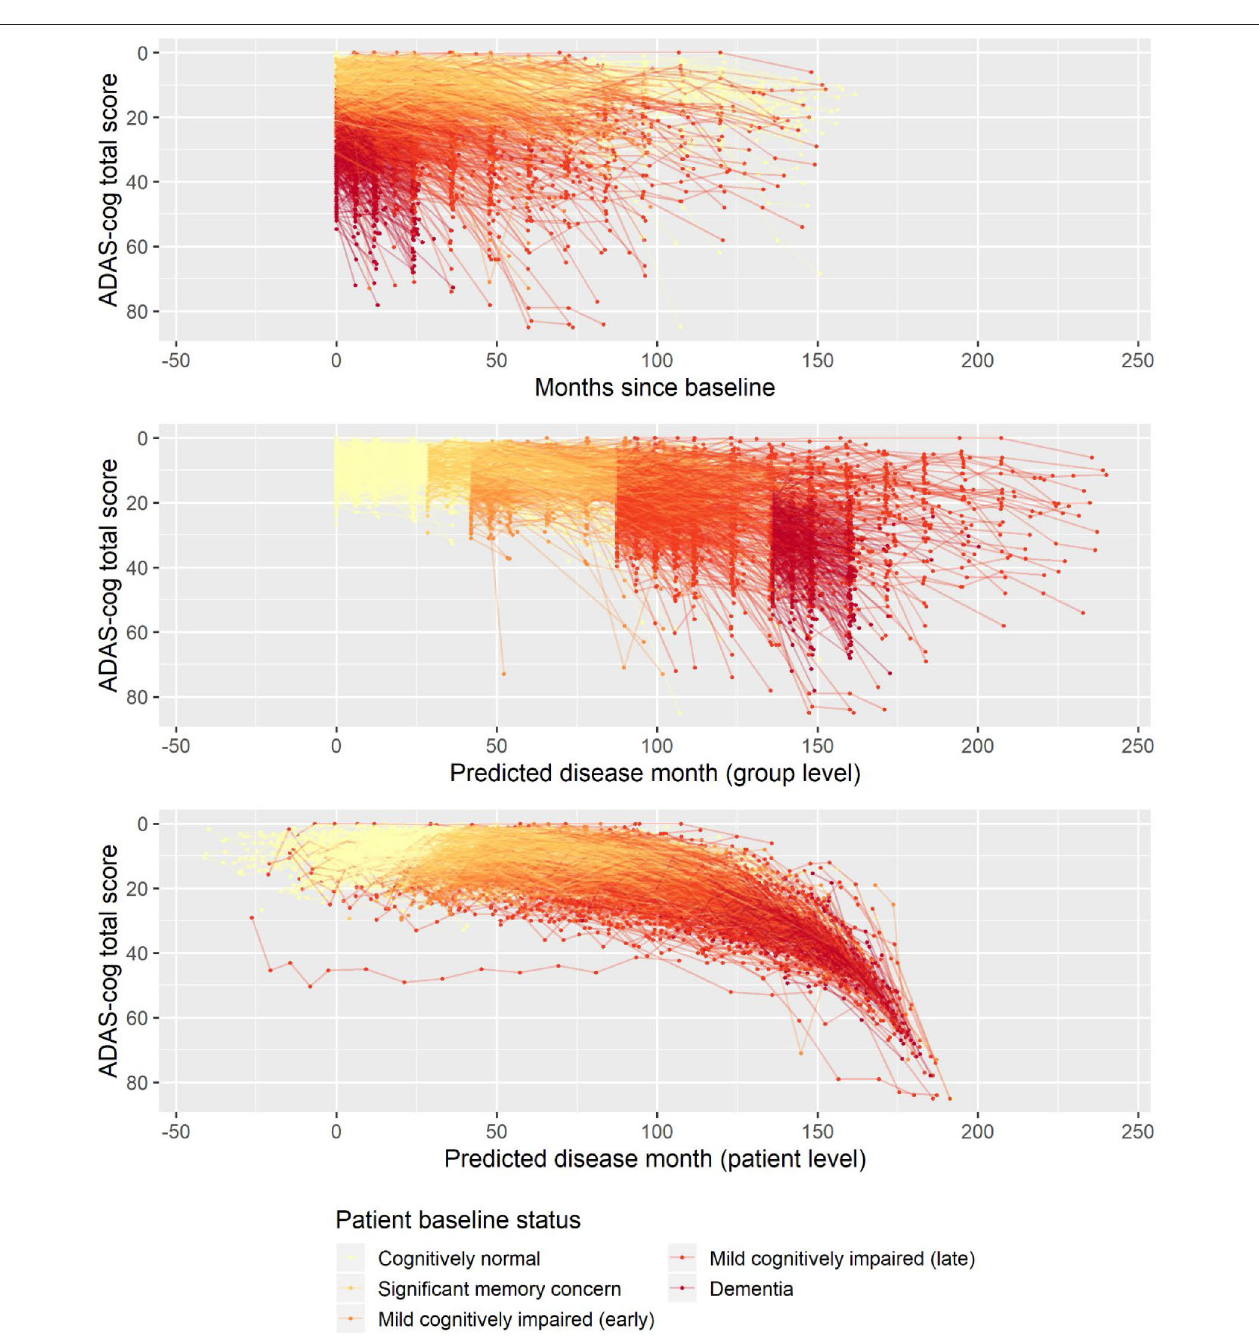
FIGURE 1 | Observed longitudinal ADAS-Cog trajectories for 2,142 ADNI participants plotted against time in study (top), predicted disease time based on the fixed-effects staging of the different patient baseline status groups relative to the cognitively normal group (middle), and predicted individual disease time based on both fixed group and random individual